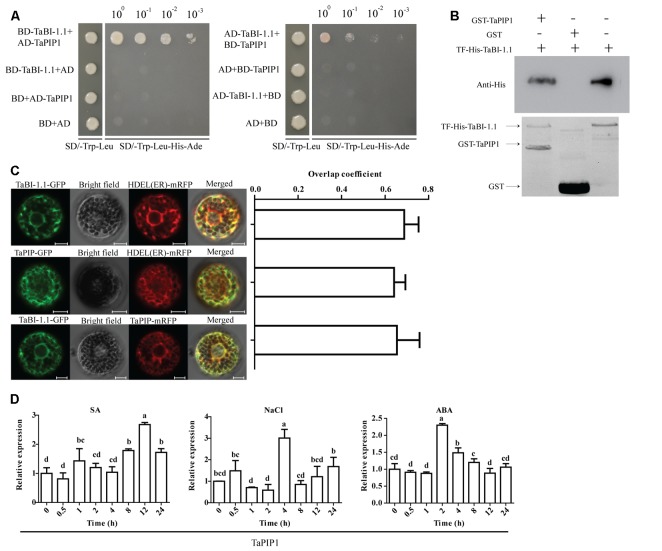
The interaction and subcellular localization of TaBI-1.1 and TaPIP1. (A) The interaction between TaBI-1.1 and TaPIP1 was measured using the yeast two-hybrid assay. Seven vector combinations were co-transformed into the yeast AH109 strain, and transformants were placed on SD/-Trp-Leu-His-Ade medium and grown for 4 days. (B) The interaction between TaBI-1.1 and TaPIP1 was measured using a pull-down assay. A western blot with an anti-His antibody was used to detect interactions, and the interaction between TF-His-TaBI-1.1 and GST was used as a control. (C) Co-localizations between TaBI-1.1-GFP and mRFP-HDEL, TaPIP1-GFP and mRFP-HDEL, TaBI-1.1-GFP and TaPIP1- mRFP in wheat protoplasts. The left panel shows the fluorescence of GFP, mRFP and the merged image. The right panel shows the levels of co-localization calculated from overlap coefficients obtained from at least 10 individual protoplasts. (D) Expression profiles of TaPIP1 after SA, NaCl, and ABA treatments for 0, 0.5, 1, 2, 4, 8, 12, and 24 h. Wheat actin was used as a reference. Vertical coordinates represent fold changes, and horizontal coordinates represent different time periods. Error bars indicate the SDs. The results represent the means ± SDs of three biological replicates. Different letters in bar graphs indicate significant differences.